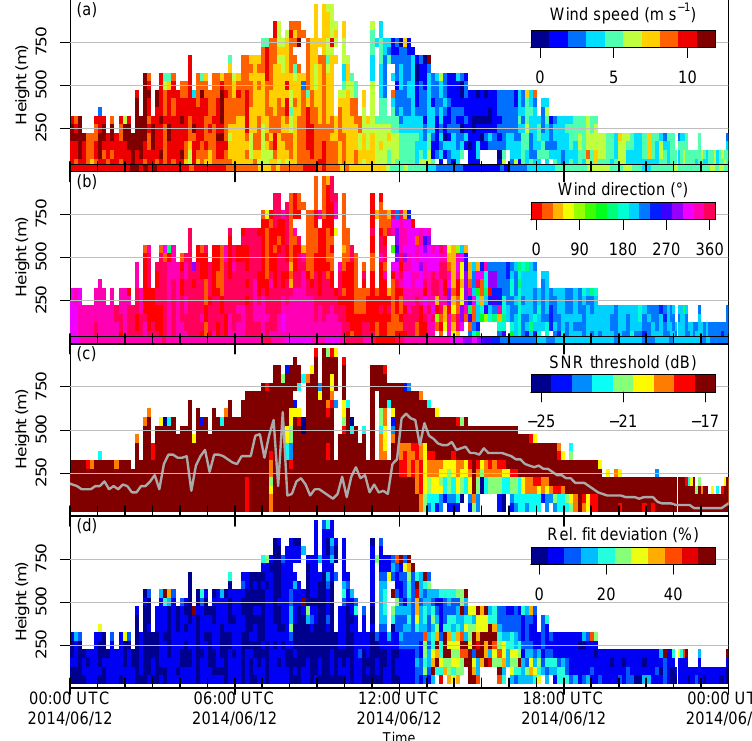
Figure 9. Lidar wind speed (a) and direction (b) for the − 25dB SNR threshold for the 12 June 2014 (location see PS85 in Fig. 1). Colours below the black line (40m) show the wind measurements of RV Polarstern (anemometer). The plot (c) presents the SNR thresholds that would allow for a wind calculation. The grey line is the cloud base from ceilometer measurements of RV Polarstern . The relative fit deviation (fit deviation divided by wind speed) is shown in (d) . Values exceeding the upper limit in (a) and (d) are included in the highest colour bar bin. Only scans with a 75 ◦ elevation were used.